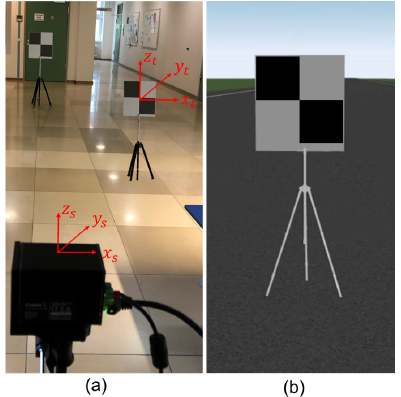
Figure 22. ( a ) Real setup for relative range tests. ( b ) Static simulation scene for relative range tests. The coordinates of the actual and simulated sensor and target are the same.